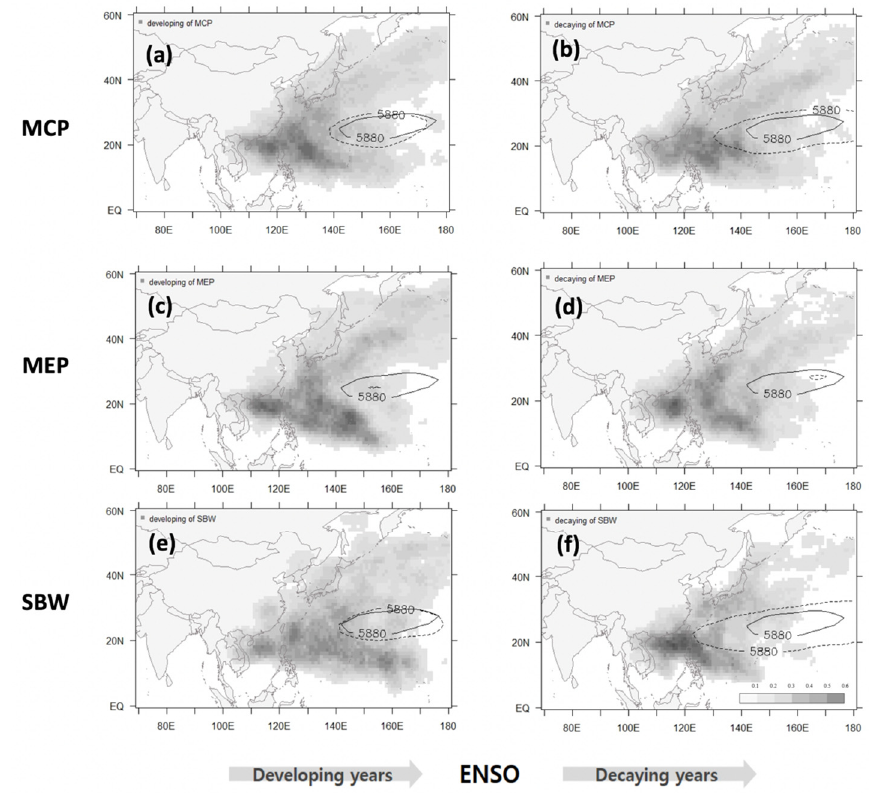
Figure 5. Comparison of subtropical highs and tropical cyclone behavior under different types of El Niño–Southern Oscillation (ENSO) events during the developing and decaying years, (( a , b ) moderate central Pacific (MCP); ( c , d ) moderate eastern Pacific (MEP); ( e , f ) strong basin-wide (SBW)). The solid line shown in each figure indicates the long-term average position of the western North Pacific (WNP) subtropical high (represented by 5880 gpm). Dashed lines indicate different types of ENSO events. The grey shading marks the average path of the tropical cyclones for each case.